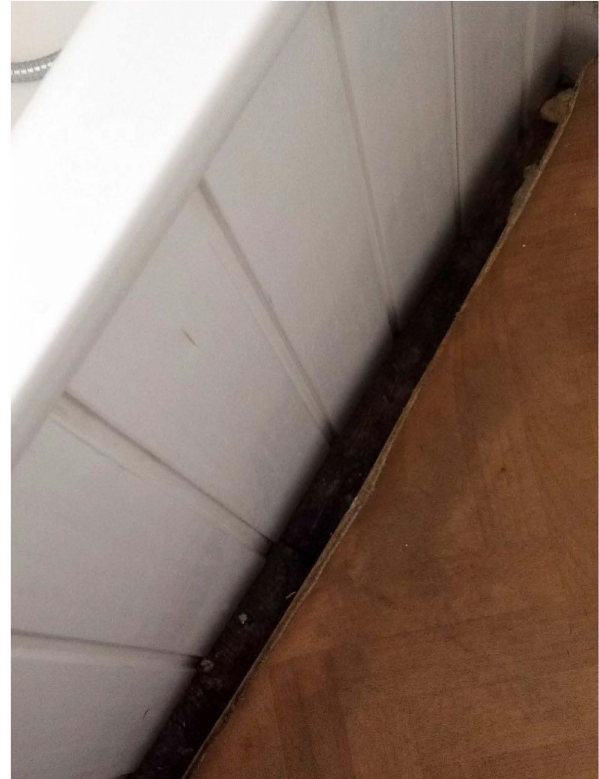
Figure 12. Participant.Survey1.